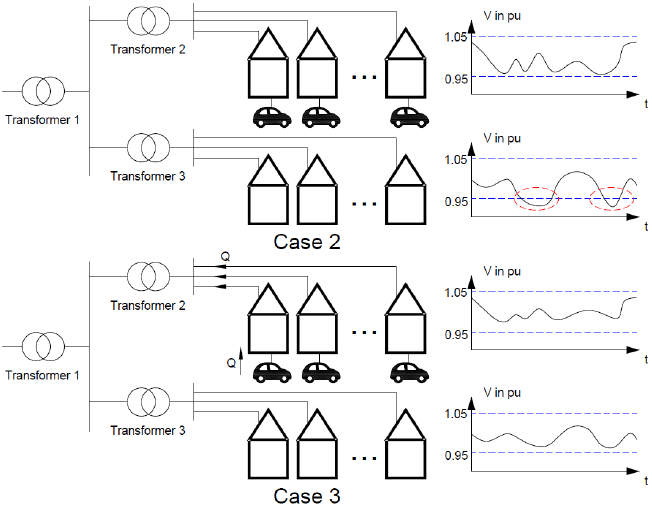
Figure 2. Impact of reactive power on the voltage profile. Case 2, without injecting reactive power, Case 3 with injecting reactive power.